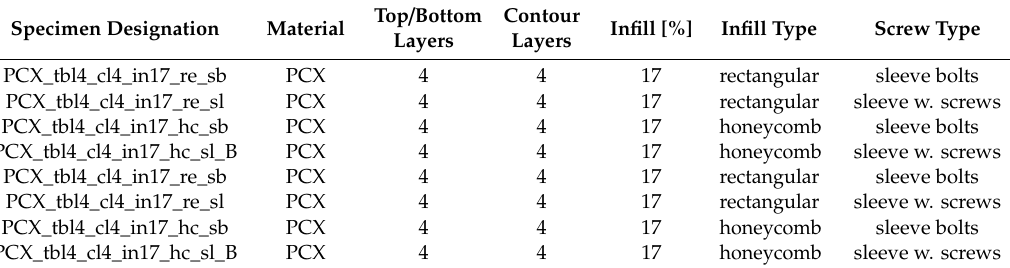
Table 2. Variation parameters test series 2.